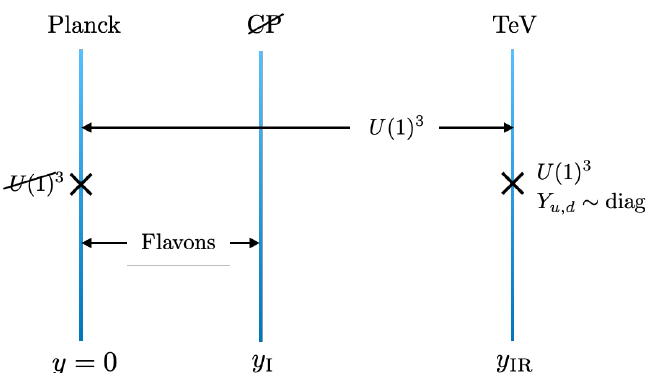
Figure 2 . A schematic picture of our setup for the U(1) 3 flavor symmetries. The U(1) 3 are spontaneously broken by VEVs of flavons in the subregion 1. The quark Yukawa couplings on the IR (TeV) brane are given by diagonal matrices due to the unbroken U(1) 3 symmetries. At the intermediate brane, the flavons couple to ¯ u and ¯ d , which lead to the terms in eqs. (3.5), (3.7). The U(1) 3 symmetries are explicitly broken on the UV